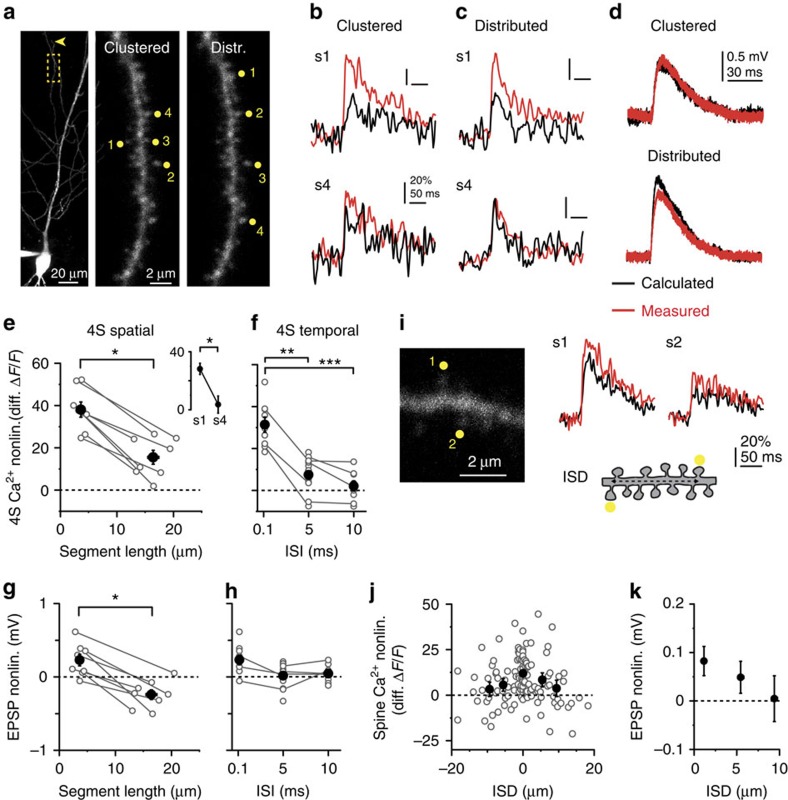
Spatiotemporal properties of cooperative spine Ca2+ signalling in distal compartments.(a) Left: low-magnification z-stack of a CA1PC, stimulation site on oblique dendrite indicated by yellow box. Arrowhead points to dendrite tip. Middle and right: high-magnification z-stack of the stimulated segment, with clustered (middle) and distributed (right) arrangement of inputs. Distributed inputs were always activated distal to proximal. (b,c) Representative Ca2+ signals from spine #1 (upper) and spine #4 (lower) in clustered (b) and distributed (c) arrangement using the 4S protocol (ISI=0.1 ms). (d) Integrated somatic EPSPs corresponding to (b,c). In b–d, black traces represent calculated responses and red traces represent measured responses. (e) Spine Ca2+ nonlinearity (average of all four spines) in clustered versus distributed arrangement (P<0.05, Wilcoxon test). Grey lines represent experiments in individual dendrites. Inset: Ca2+ nonlinearity from spine #1 (first, most distal) and #4 (last, most proximal) in experiments with distributed input. (f) Dependence of Ca2+ nonlinearity on input synchrony using clustered arrangement in distal dendritic segments (n=9–14 spine sets in 17 dendrites, seven cells, multiple comparisons after Kruskal–Wallis test with P<0.001). Grey lines represent experiments on the same spine set. (g,h) Somatic EPSP nonlinearity as a function of the dendritic segment length for spatial distribution (g, P<0.05, Wilcoxon test), and of ISI (h, clustered stimulation, ISD<6 μm, no significant differences with multiple comparisons after Kruskal–Wallis test with P=0.044). (i) Left: single 2P image of a distal segment with two stimulated spines indicated. Right: Ca2+ signals in the two spines during synchronous stimulation. Cartoon depicts measurement of interspine distance (ISD). (j) Ca2+ cooperativity among spine pairs as a function of ISD (n=122 spines). Positive or negative ISD value represents spine sequence towards tip or soma, respectively. Symbols represent mean±s.e.m. for data binned in 0±2.5, 2.5–7.5 and 7.5–12.5 μm. Kruskal–Wallis test for 0±2.5 (n=62), 2.5–7.5 (n=27) and 7.5–12.5 μm (n=23) bins, P=0.003. (k) EPSP nonlinearity as a function of ISD (grouped by absolute ISD values binned as in j). Filled symbols and error bars represent mean±s.e.m. distr., distributed; nonlin., nonlinearity.